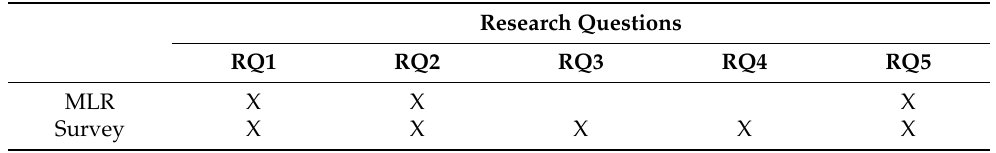
Table 1. Summary of methods used to answer research questions.